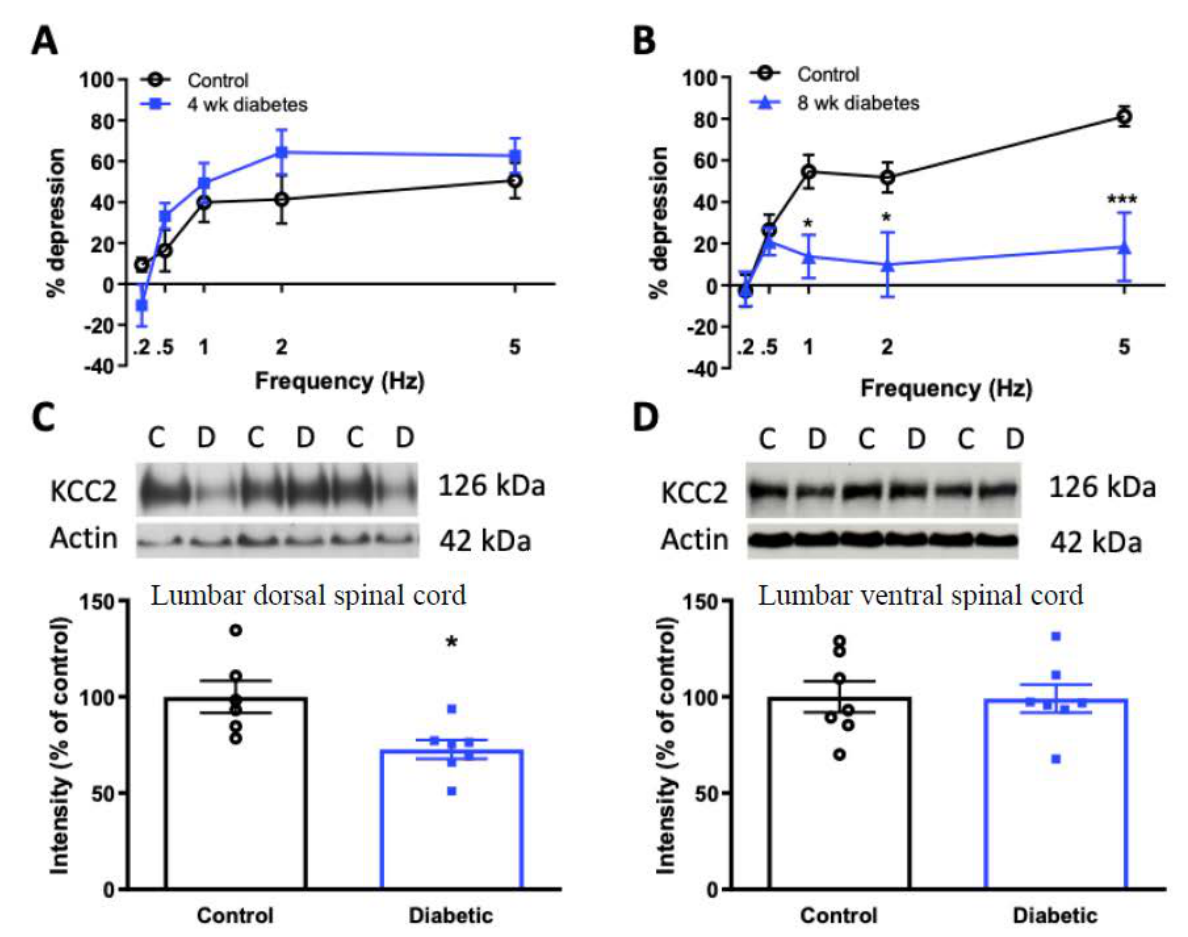
Figure 2. RDD and KCC2 expression in diabetic rats. % depression of the H-reflex over consecutive stimulation at 0.2–5 Hz frequencies in ( A ) 4-week diabetic rats (blue squares) and ( B ) 8-week diabetic rats (blue triangles), compared to age-matched non-diabetic controls (closed black circles). * p < 0.05, *** p < 0.001 by two-way ANOVA followed by Bonferonni’s post-hoc test. n = 11–3 per group. ( C ) Upper panel: KCC2 and actin protein in the lumbar dorsal spinal cord of control ( C ) and 4-week diabetic ( D ) rats. Lower panel: KCC2 intensity by Western blot normalized to actin loading control. ( D ) Upper panel: KCC2 and actin protein in the lumbar ventral spinal cord of control ( C ) and 4-week diabetic ( D ) rats. Lower panel: KCC2 intensity by Western blot normalized to actin loading control. Data are presented as group mean ± SEM. * p < 0.05 by unpaired two-tailed t-test. n = 7 per